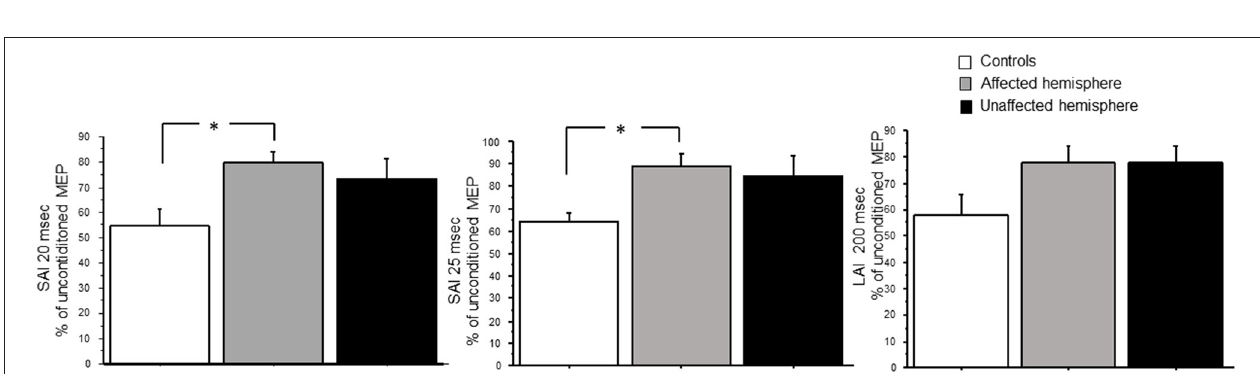
FIGURE 3 | SICI and ICF in controls and patients with brain tumors (affected and unaffected hemispheres). Mean amplitude of the conditioned MEP was expressed as percentage of the amplitude of the unconditioned MEP. The relative change in MEP amplitude induced by the conditioning stimulus characterized the strength of SICI and ICF. * p < 0.05.